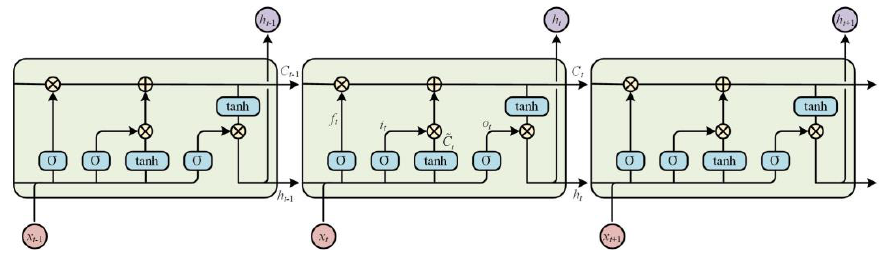
Figure 4. Schematic diagram of LSTM structure.